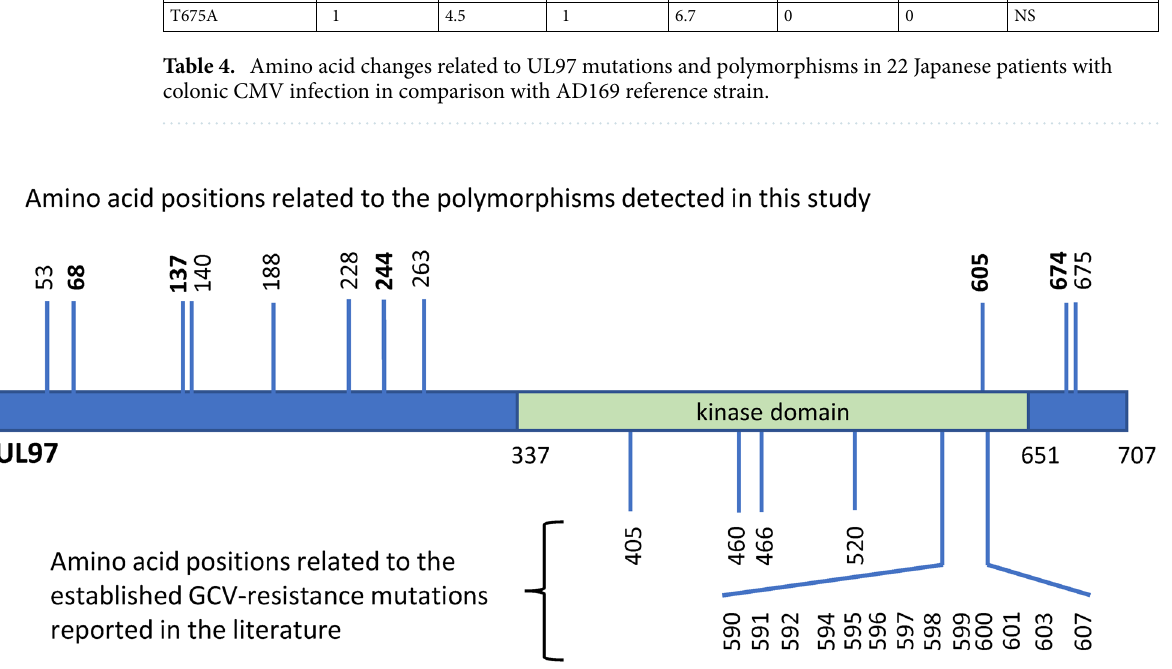
Figure 2. Schematic diagram of natural polymorphisms and GCV-resistant mutations in pUL97. The kinase domain is located between amino acids 337 and 651. All amino acid positions related to the established GCV- resistance mutations reported in the literature are indicated below. Interaction region for GCV is defined by the location of resistance mutations detected within the kinase domain so far (405, 460, 466, 520, 590, 591, 592, this study are indicated above. Natural polymorphisms that have been reported in the literature are indicated in bold 32